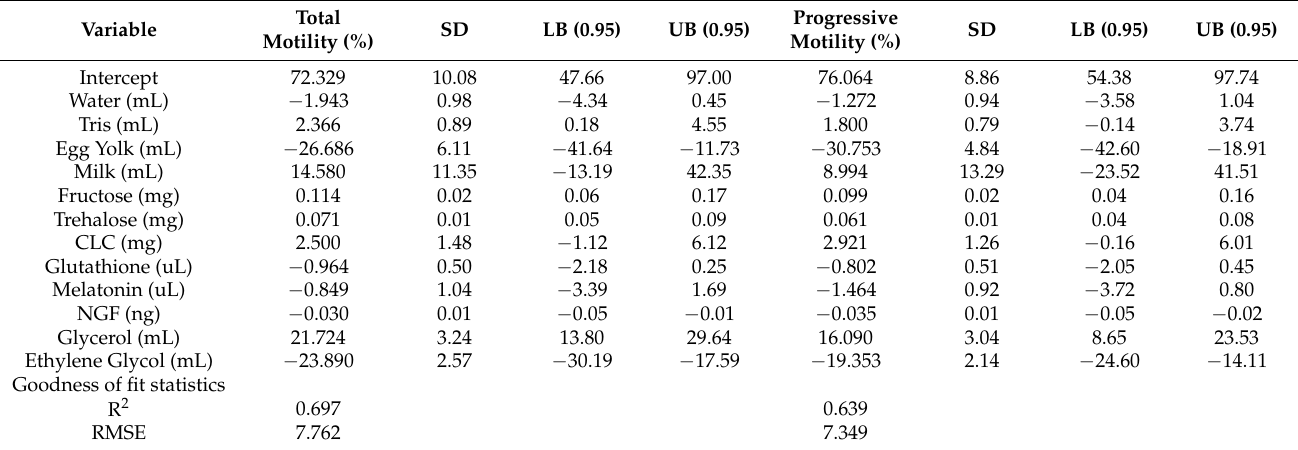
Table 3. The parameters generated by the PLS regression models and the goodness of fit statistics for total and progressive motility ( n = 300).